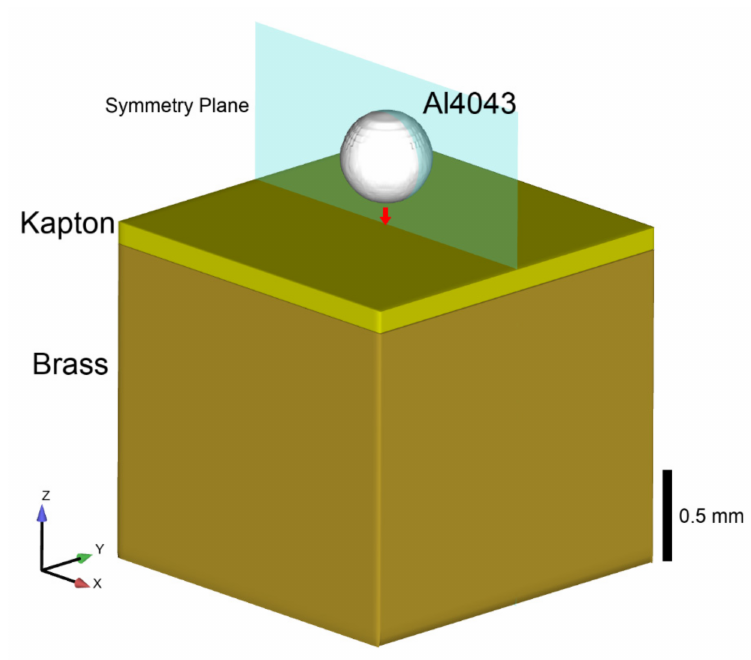
Figure 4. Schematic of the droplet impingement